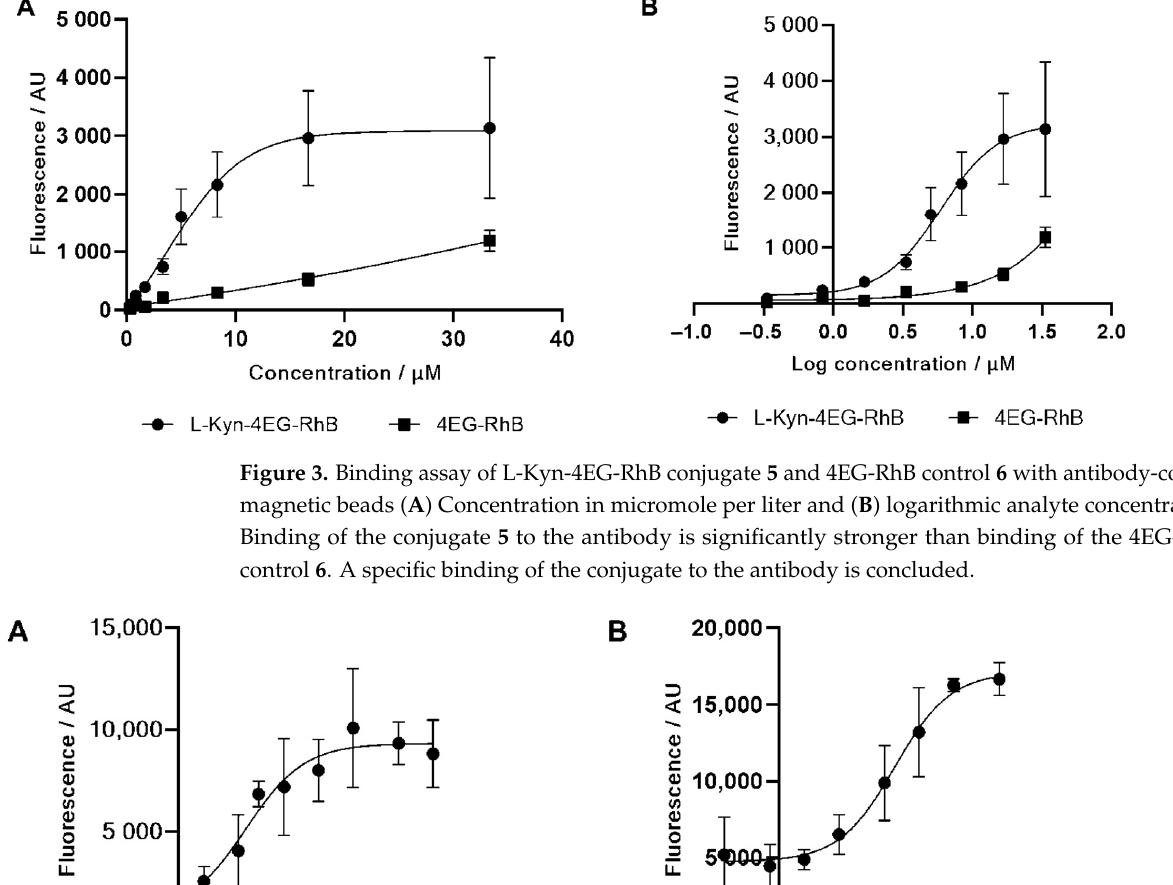
Figure 3. Binding assay of L-Kyn-4EG-RhB conjugate 5 and 4EG-RhB control 6 with antibody-coated magnetic beads ( A ) Concentration in micromole per liter and ( B ) logarithmic analyte concentration.